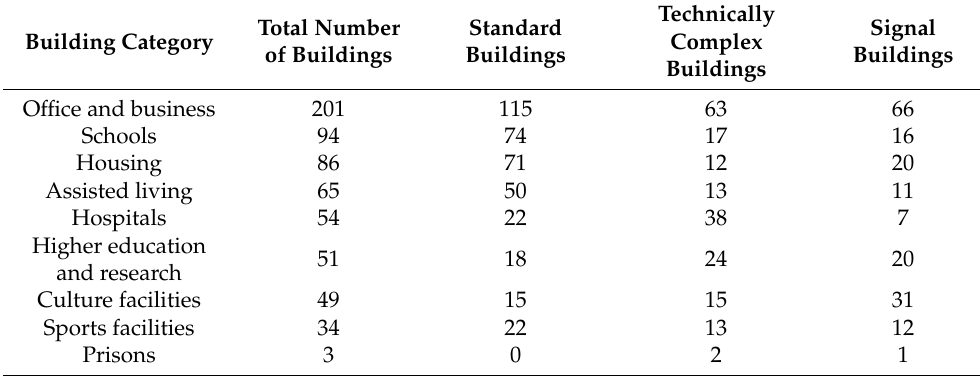
Table 2. The respondents’ building projects.